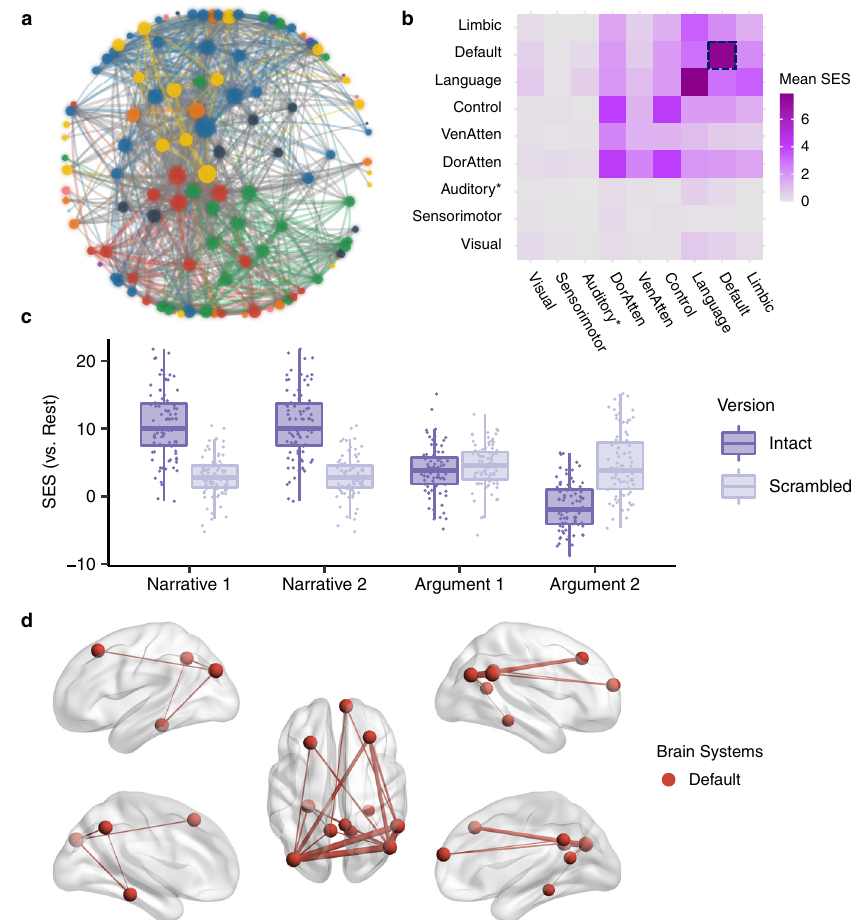
Fig. 8 The brain network speci fi c to narrative thought. a The network layout of the brain network speci fi c to narrative thought using the force-directed graph drawing algorithm. For clarity, we only included the top 995 out of 2224 signi fi cant edges with the largest standardized effect size (SES) in the contrast between the intact- and the scrambled-narrative conditions (i.e., network density equals 5%, as there were 19,900 potential edges). The color legend is the same as the one in Figs. 4, 5. b The distribution of all the 2224 edges within and between brain systems, where each cell indicates the mean SES in the contrast between the intact- and the scrambled-narrative conditions, i.e., the ratio of the sum of the SES to the number of the edges in the fully connected situation. There were 87 edges in the DMN, which are highlighted in the dotted box. c The SES of the edges of all the conditions in contrast to the resting state in the DMN. d The top 20 edges in the DMN with the largest SES in the contrast between the intact- and the scrambled-narrative conditions. In a , d the size of the nodes denotes the node degree of each brain area in the whole graph comprising 2224 edges. The color of the nodes denotes to which brain system they belong. The width of the edges denotes the SES. Intra-system edges are in the color of that network; inter-system edges are in